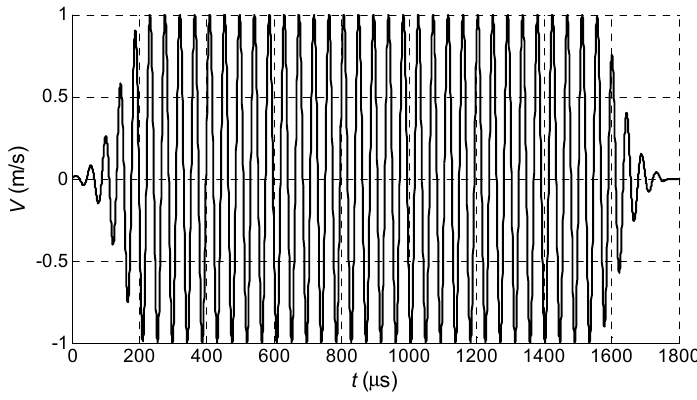
Figure 9. Particle velocity impulse V radiated by an array element: the main frequency 22.62 kHz.